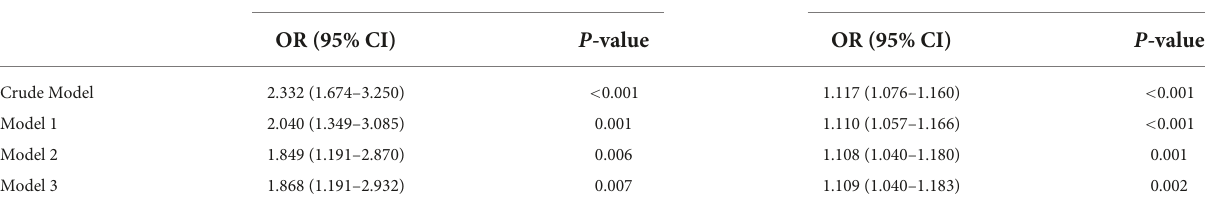
TABLE 4 Predictive value of GA for the risk of ISR.